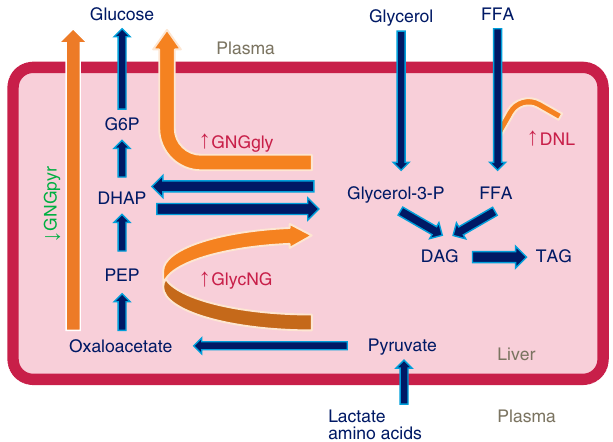
Figure 5 | Biochemical model of regulation of glucose and triglyceride synthesis in NAFLD. Tight balance between glyceroneogenesis (GlycNG) and gluconeogenesis from glycerol (GNGgly) in NAFLD patients may help maintain the glycemic control, but at a cost of lower adaptability of the global metabolic network. This balance breaks down in type 2 diabetes, where gluconeogenesis from pyruvate (GNGpyr) is markedly increased.DAG, diacylglycerol; DHAP, dihydroxyacetone phosphate; DNL, de novo lipogenesis; FFA, free fatty acid; G6P, glucose-6-phosphate; PEP, phosphophenol pyruvate; TAG, triacylglycerol.